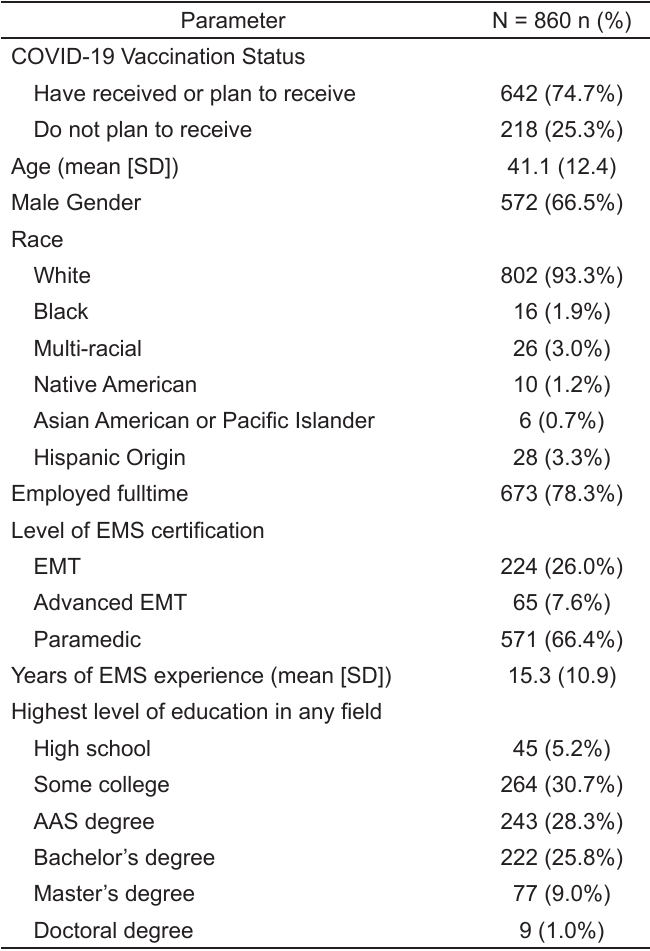
Table 1. Sociodemographic characteristics of